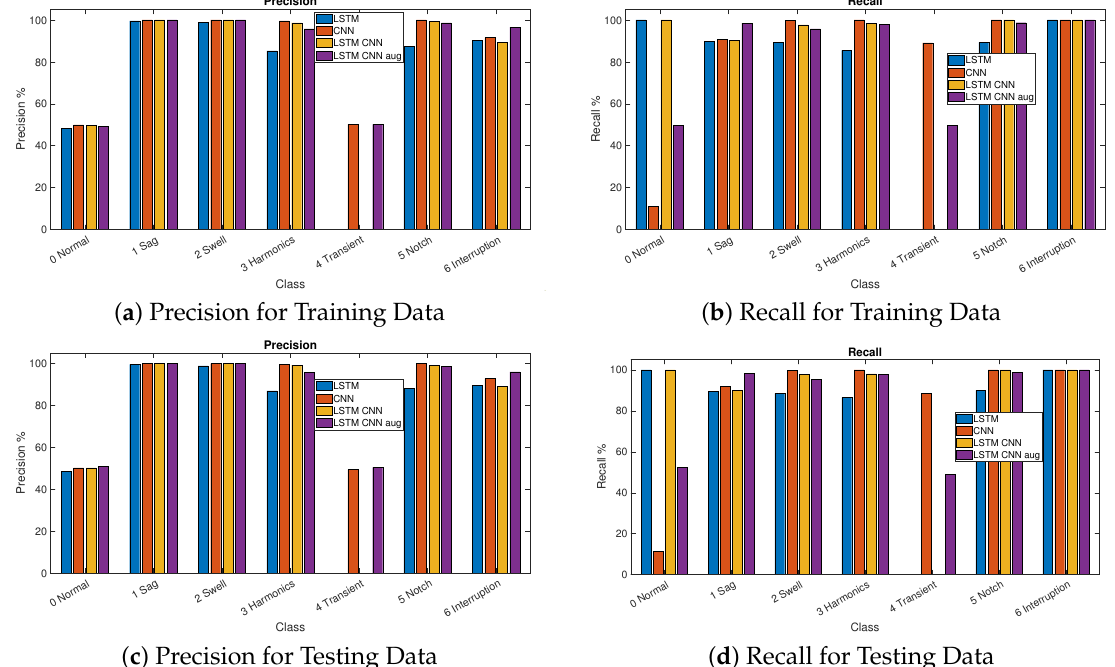
Figure 13. Bar chart of the comparison of the precision and recall of the LSTM (blue), CNN (red), LSTM-CNN(yellow) and LSTM-CNN with adjusted hyperparameters(purple). ( a ) Precision Training Data, ( b ) Recall Training Data, ( c ) Precision Testing Data, ( d ) Recall Testing